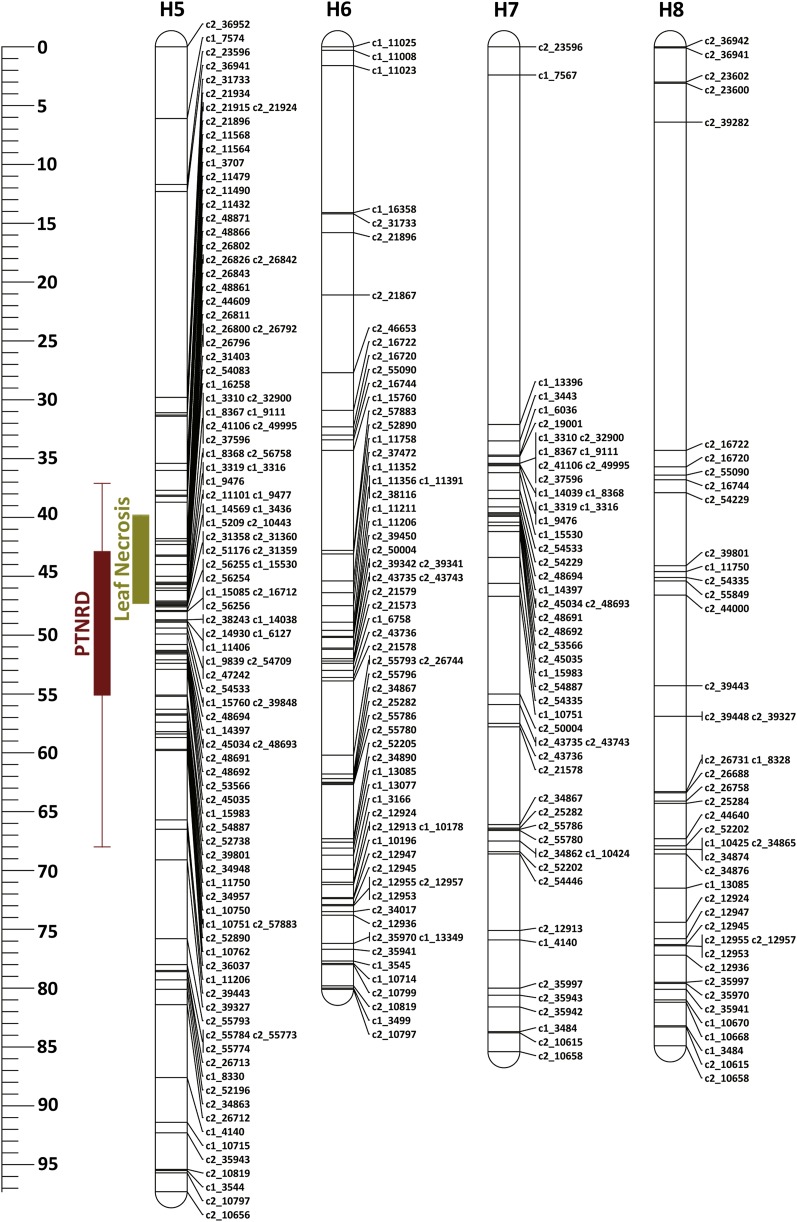
Linkage map of Pike chromosome 4 (H5–H8 = homologous maps). The brown and olive green bars correspond to the support LOD intervals for the QTL locations for PTNRD and Leaf Necrosis, respectively. For each bar, whiskers represent the two LOD support interval and the solid box represents the one LOD support interval for the QTL location. LOD, logarithm of the odds; PTNRD, potato tuber necrotic ringspot disease; QTL, quantitative trait loci.